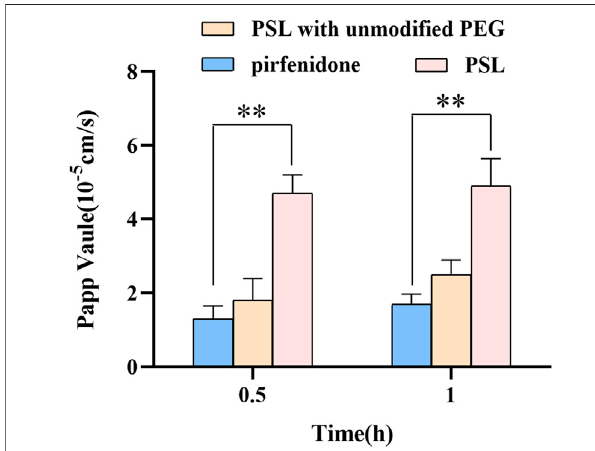
FIGURE 3 | P app of PSLs, PSLs with unmodi fi ed PEG, and pirfenidone during incubation with arti fi cial sputum medium (P app : The apparent permeability coef fi cient. PSL unmodi fi ed with PEG: Pirfenidone pH-sensitive liposomes without surface modi fi cation with PEG 2000; ** p < 0.01, n = 3).